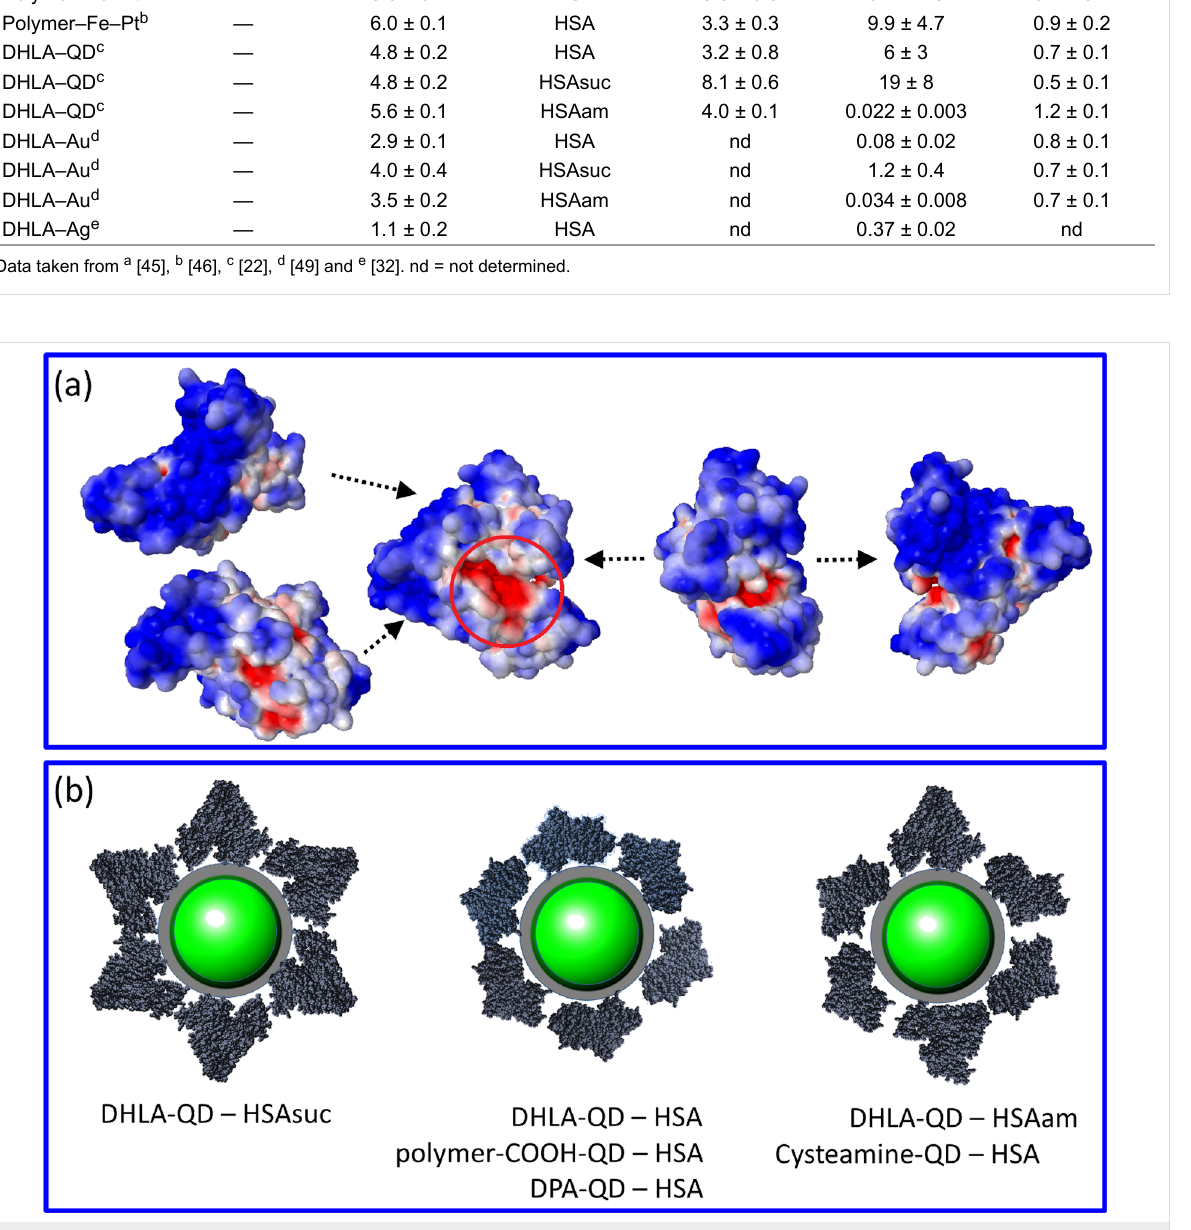
Figure 4: (a) Surface electrostatics of HSA (PDB code: 1UOR) at pH 7.4 (range − 5 k B T / e to +5 k B T / e ; calculated online at http://nbcr-222.ucsd.edu/ pdb2pqr_1.8 [53]). The potential is represented in graduating colors from dark blue (most negative) to light blue, white, light red to red (most positive). Different views are shown, including the views of the two triangular faces, where the positive region on one of these faces is marked by the red circle, as well as the views of the three smaller sides; arrows indicate the connectivity between the faces. (b) Schematic depiction of HSA monolayers on CdSe/ZnS QDs (green) with different surface coatings. Left: side-on, upright adsorption of a more negatively charged HSAsuc on negatively charged QDs forms a corona of ≈ 8 nm; center: face-on adsorption via the positive region on negatively charged QDs results in a radius increase of 3.2 nm; right: a corona thicker than 3.2 nm is generated by adsorption in a more random